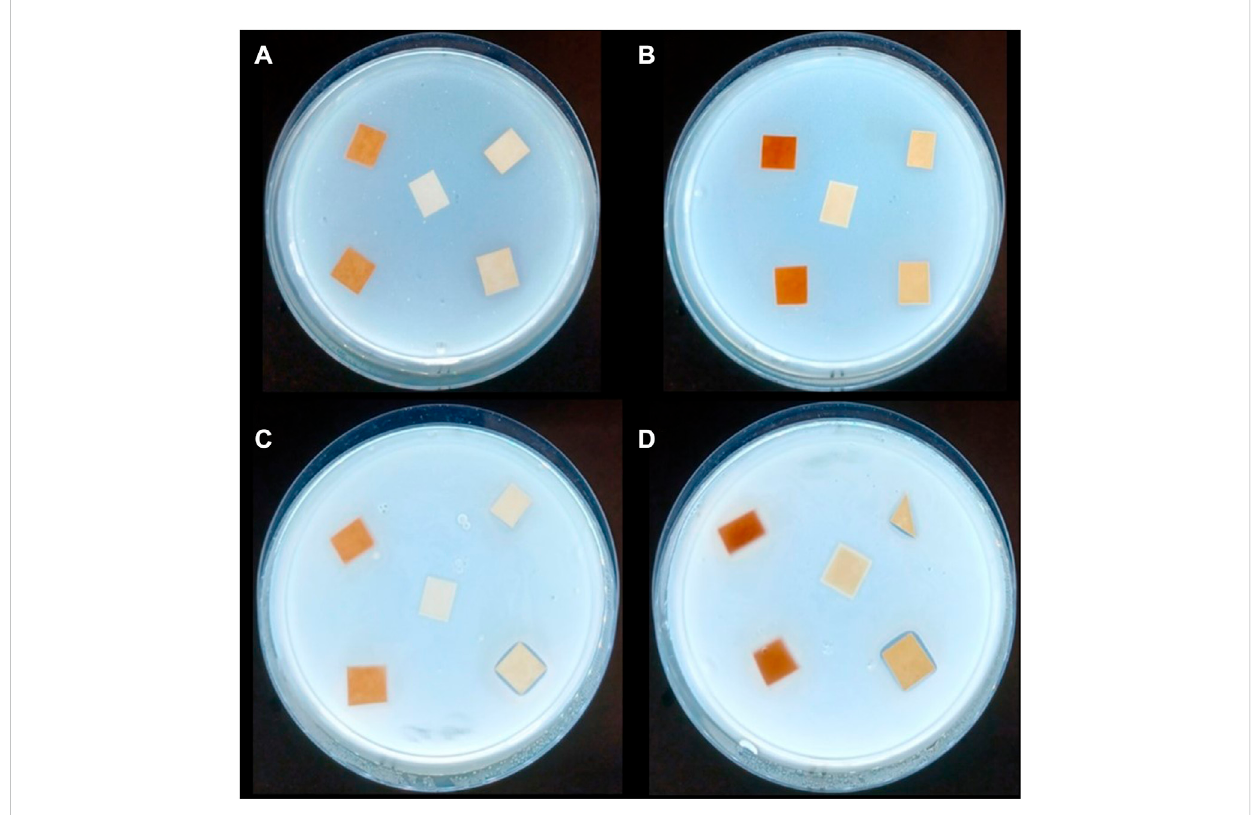
The sample papers in Petri dishes with E. coli (A) 60 g/m 2 and (B) 130 g/m 2 and S. aureus (C) 60 g/m 2 , and (D) 130 g/m 2 . Control or 0-paper is in the middle and others are in clockwise order starting from the upright: TA 2%, TA 4%, TW 2%, and TW 4% for all the plates (A – D) . Three identical Petri dishes were prepared for each sample